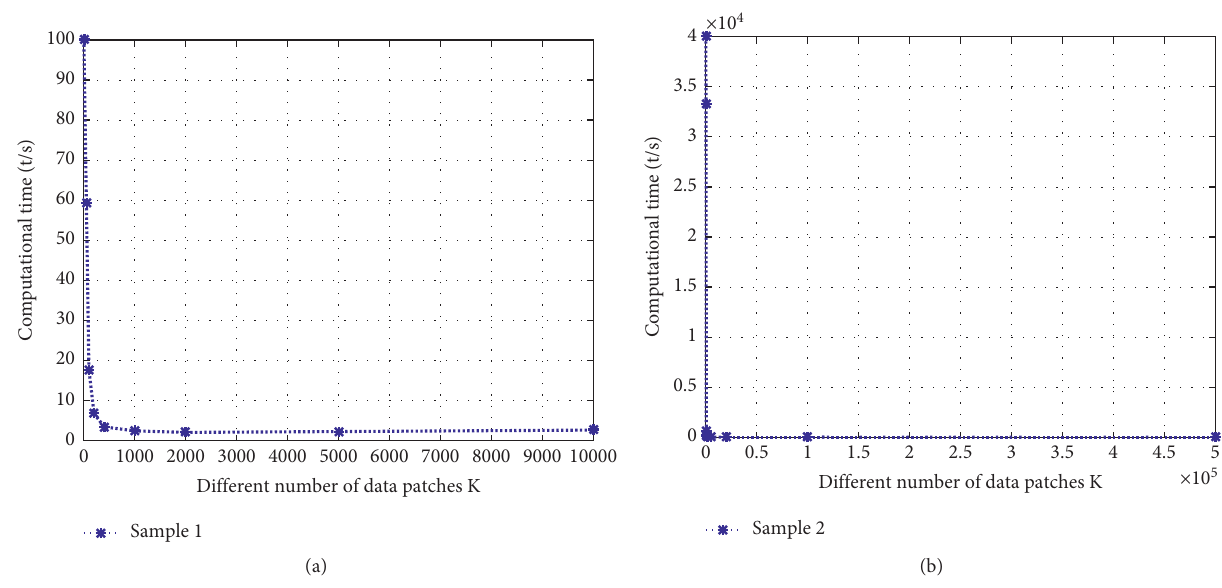
Figure 2: The relationship between the calculation time of sample (1) and sample (2) and the number of dataset blocks. (a) Sample (1). (b) Sample (2).